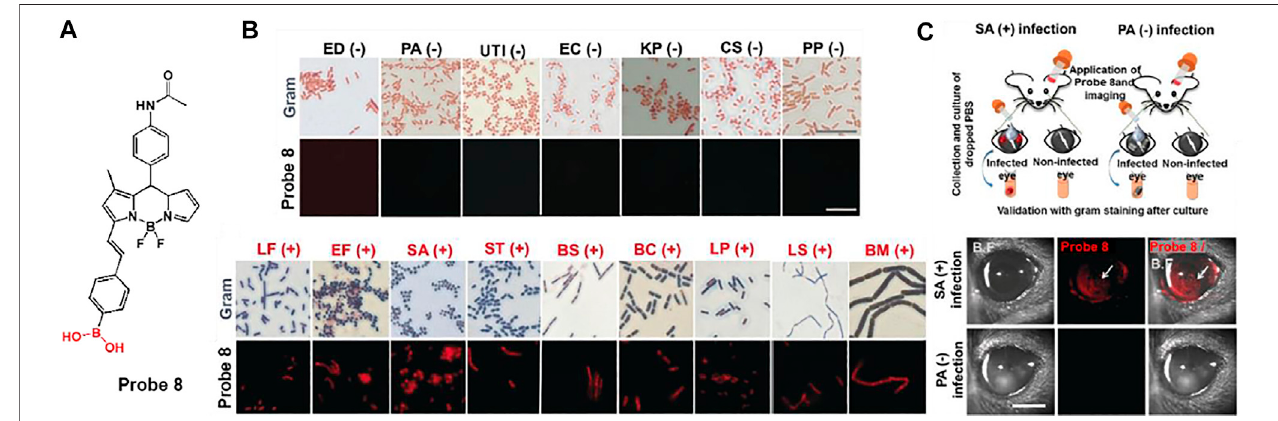
FIGURE 5 | (A) Chemical structure of probe 8. (B) Gram staining and fl uorescence-based staining of 16 bacterial strains. (BC, Bacillus cereus ; BM, Bacillus megaterium ;BS, Bacillussubtilis ;CS; Cronobactersakazakii ;EC, Escherichiacoli ;ED, EscherichiacoliDH5a ;UTI, EscherichiacoliUTI89 ;EF, Enterococcusfaecalis ;KP, Klebsiella pneumoniae ; LF, Lactobacillus fermentum ; LP, Lactobacillus plantarum ; LS, Lactobacillus sakei ; PA, Pseudomonas aeruginosa ; PP, Pseudomonas putida ; SA, Staphylococcus aureus ; ST, Streptococcus thermophilus ) (C) Fluorescence imaging in eye-infection model. Reproduced with permission from Kwon et al. (2019). Copyright © 2019, Wiley-VCH Verlag GmbH & Co. KGaA,